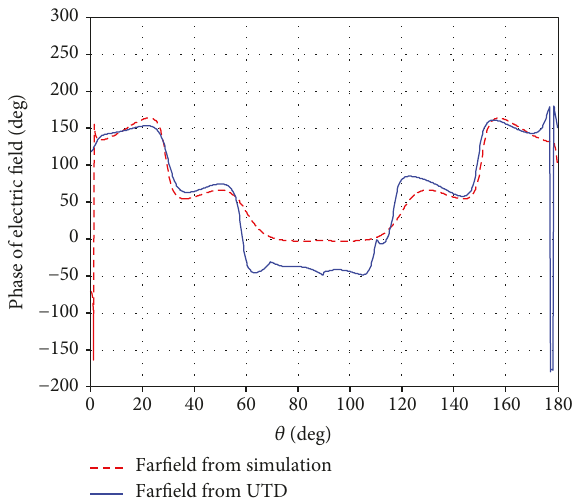
Figure 17: Absolute value of electric fi eld in the ϕ =40 ° plane with w =10 λ and h =1 λ , at 4 GHz compared with simulation result.